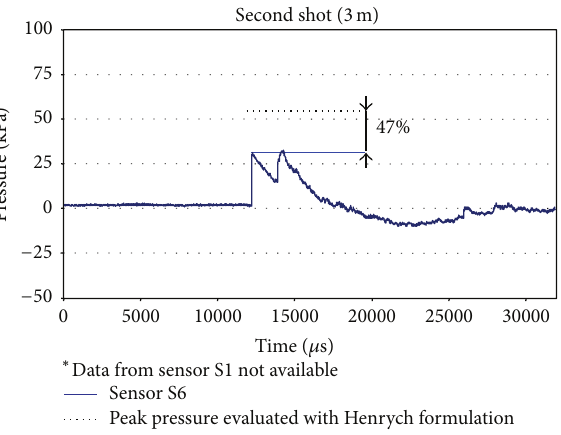
Figure 8: Acquired pressure histories: second blast.